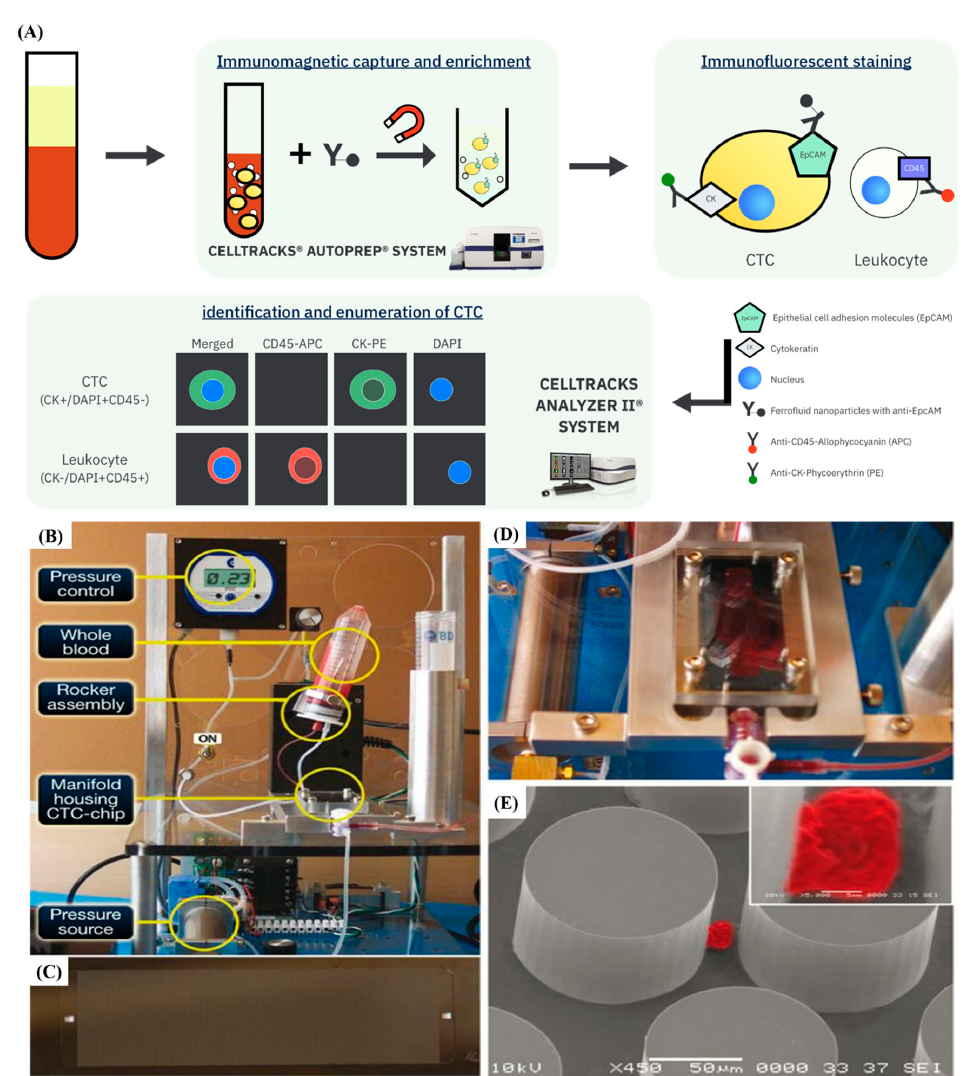
device can be used repeatedly to isolate adherent CTCs from the blood with a capture rate of about 50% (Figure 3B–E) [64].